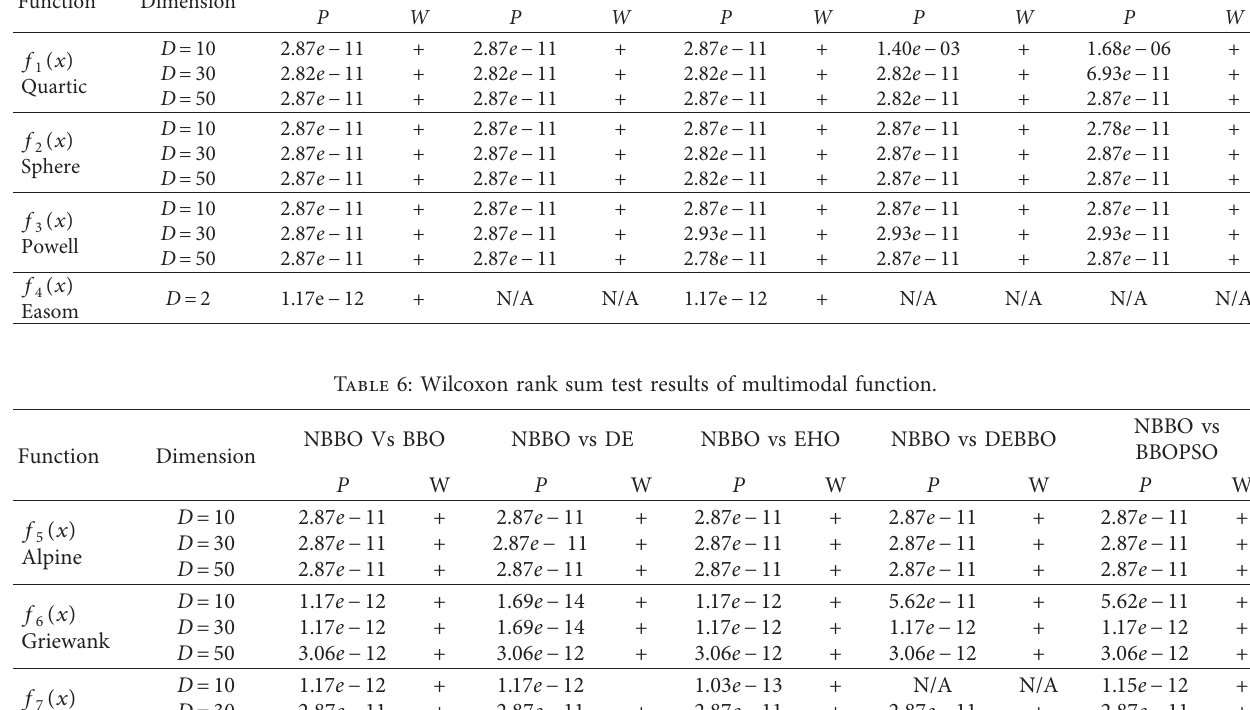
Figure 3: Multimodal function simulation results diagram, (a) f : Griewank ( d � 10 ) , (e) f f 6 f : Ackley ( d � 50 ) , (j) f 7